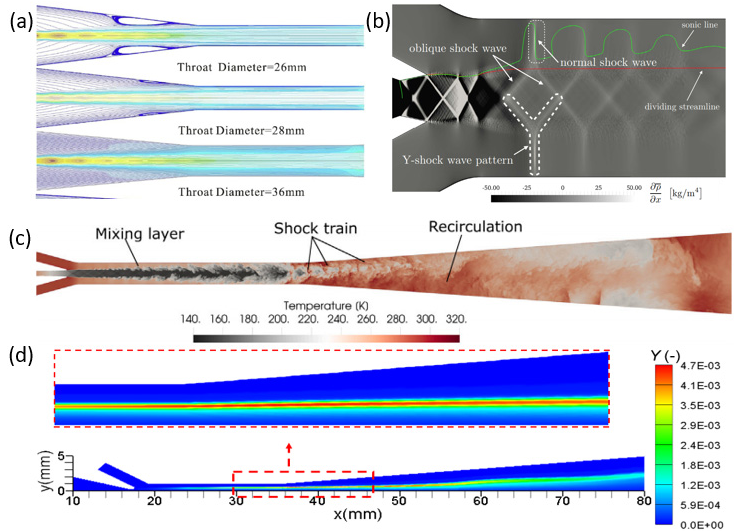
Figure 3. Complicated flow characteristics in ejectors: ( a ) flow separation [20], ( b ) shock [21], ( c ) flow instability [22], and ( d ) two-phase flow [19].